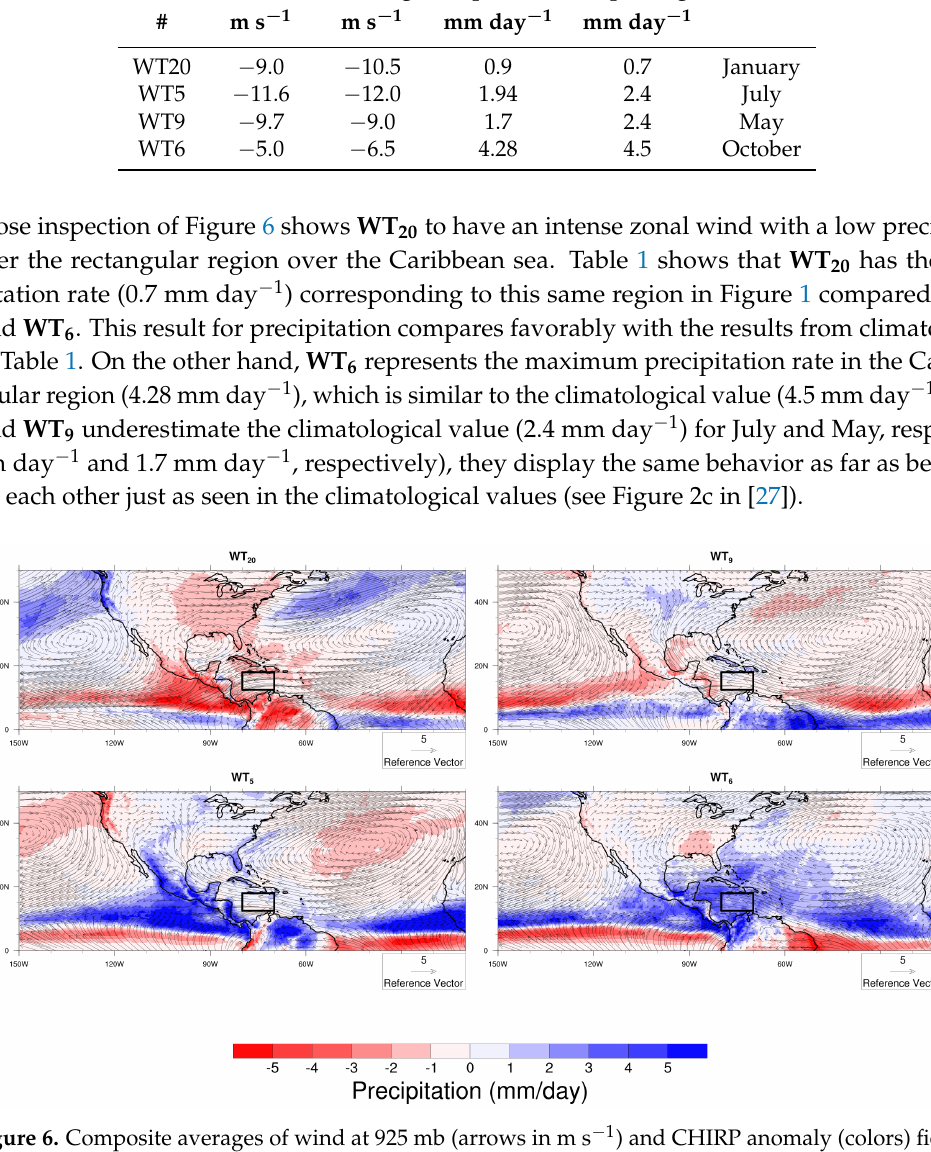
Table 1. Zonal wind (U) and precipitation (Pcp) area average for the maxima and minima reported by Wang [27] and calculated with a SOM catalog. WT U-SOM U-Wang Pcp-SOM Pcp-Wang Month # m s − 1 m s − 1 mm day − 1